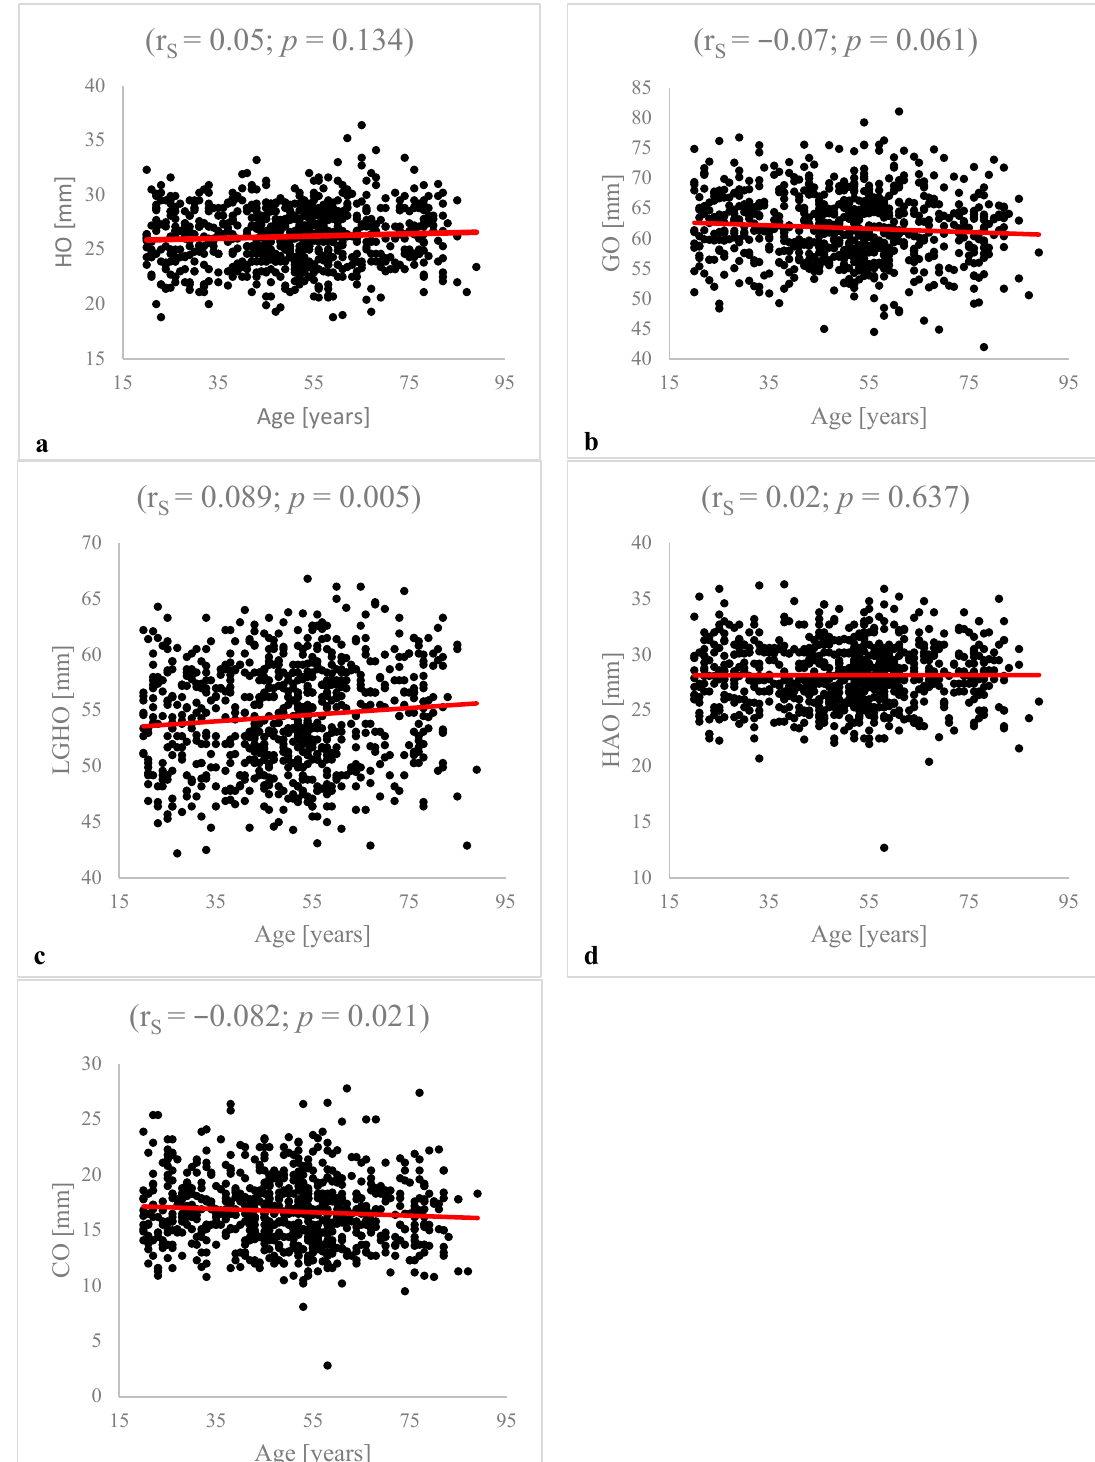
correlations between age and HO ( p = 0.134), GO ( p = 0.061) or HAO ( p = 0.637). The results of the correlation analysis are summarized in Figure 2.